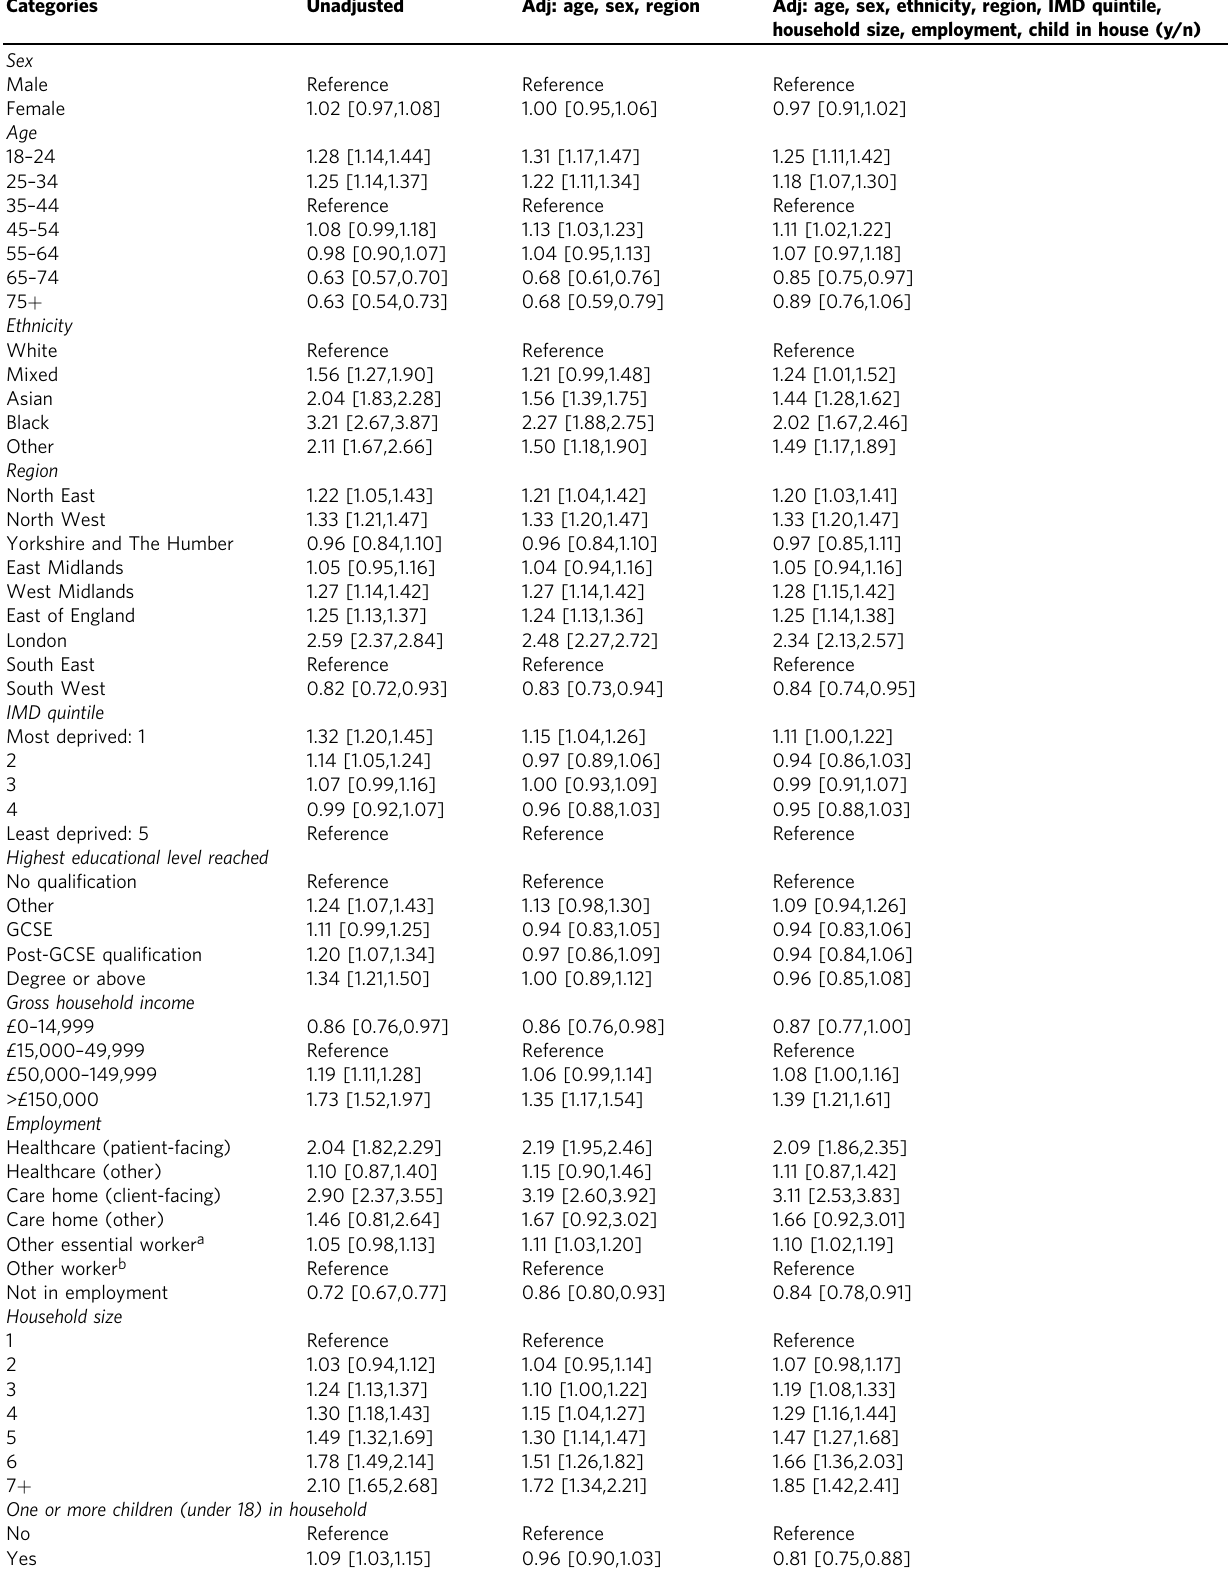
Table 1 Logistic regression analysis for prevalence of IgG antibodies to SARS-CoV-2.